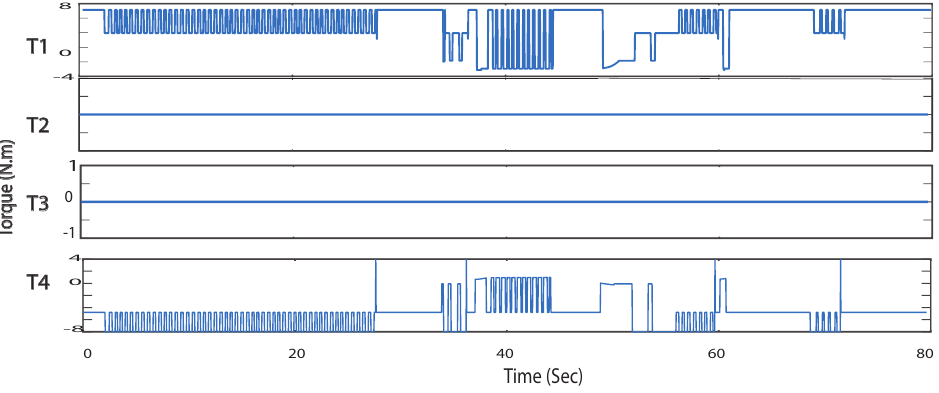
Figure 15. Simulation Results for State 4: Torque of motor